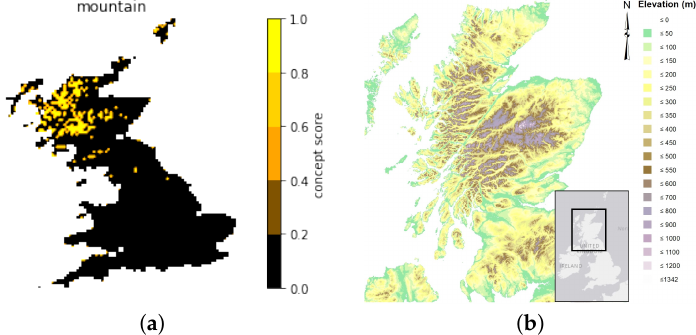
Figure 7. ( a ) Mountain concept score; ( b ) Elevation map of the northern